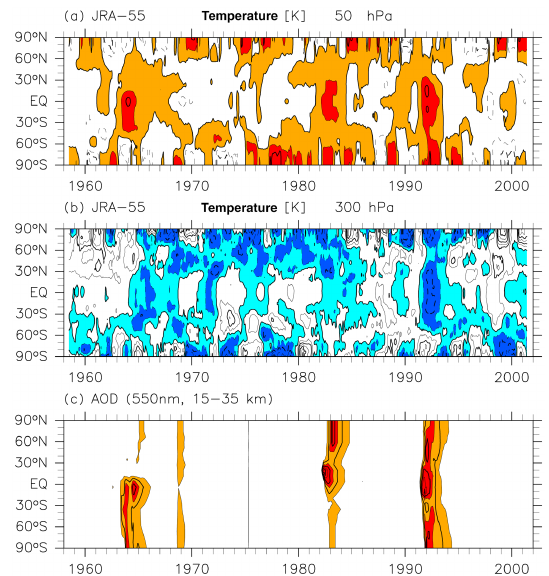
Figure 9. Time-latitude distribution of temperature residual R(t) (including volcanic signals and random variations) for the 1958– 2001 regression analysis from JRA-55 reanalysis data at (a) 50hPa and (b) 300hPa. Thirteen-month running average has been taken for R(t) . The contour interval is 1.0K for (a) and 0.25K for (b) . The regions with 0–1K ( > 1K) are coloured in orange (red) in (a) . The regions with 0 to − 0.25K ( < − 0.25K) are coloured in light (dark) blue. (c) Time-latitude distribution of aerosol optical depth at 550nm integrated for the region 15–35km. The contour interval is 0.04. The regions with 0.04–0.12 ( > 0 . 12) are coloured in orange (red) in (c)